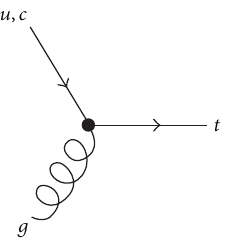
Figure 5: Leading order diagram for a “very single top” produced by an anomalous (FCNC) coupling of the kind 𝑢𝑡𝑔